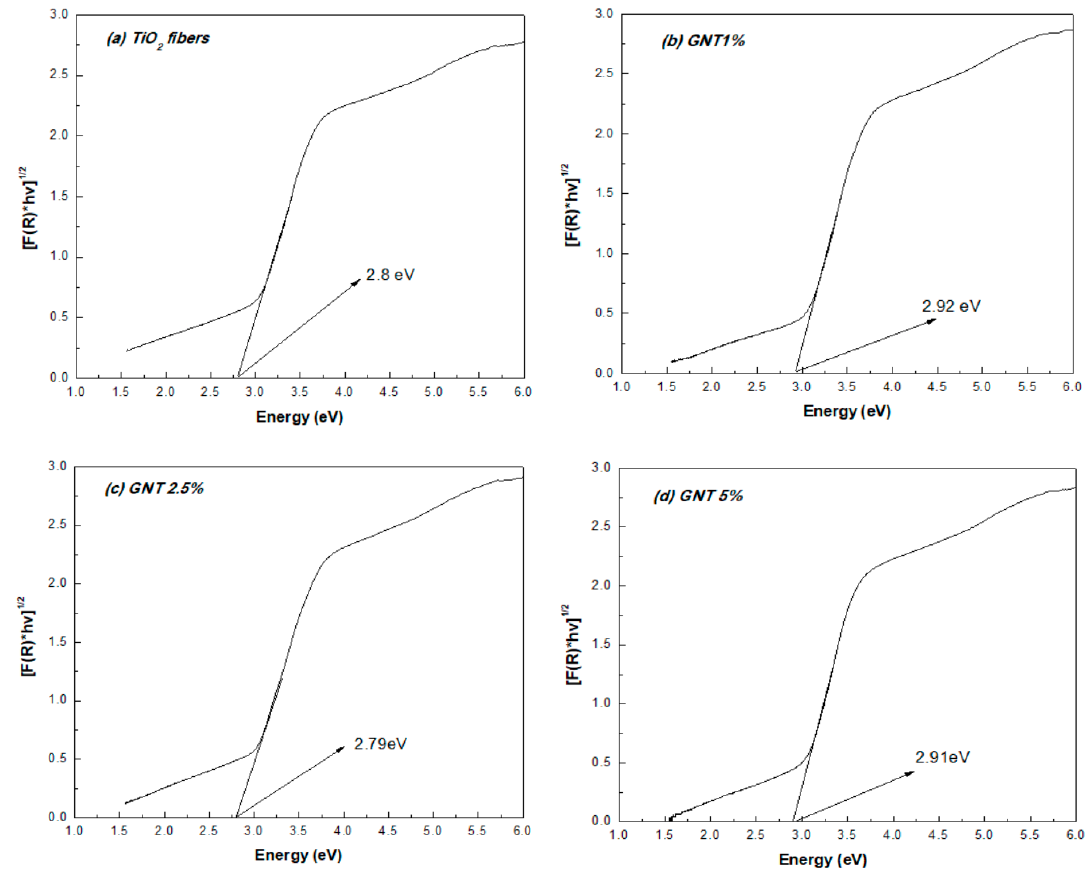
Figure 7. Kübelka-Münk plots for calcinated TiO 2 and TiO 2 / g-C 3 N 4 fibers. ( a ) TiO 2 ( b ) GNT1%; ( c ) GNT2.5%; ( d ) GNT5%.